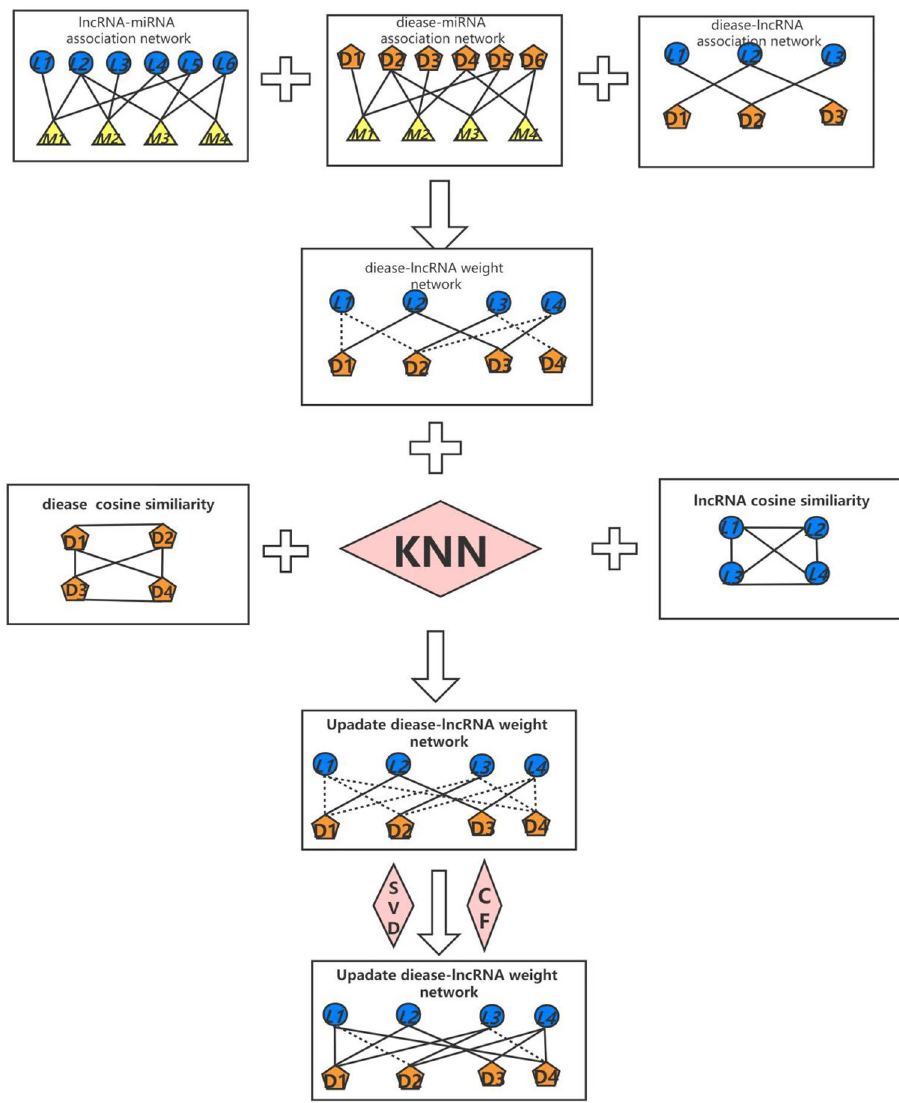
Figure 6. Flow Chart of ENCFLDA Applied to lncRNA-Disease Association